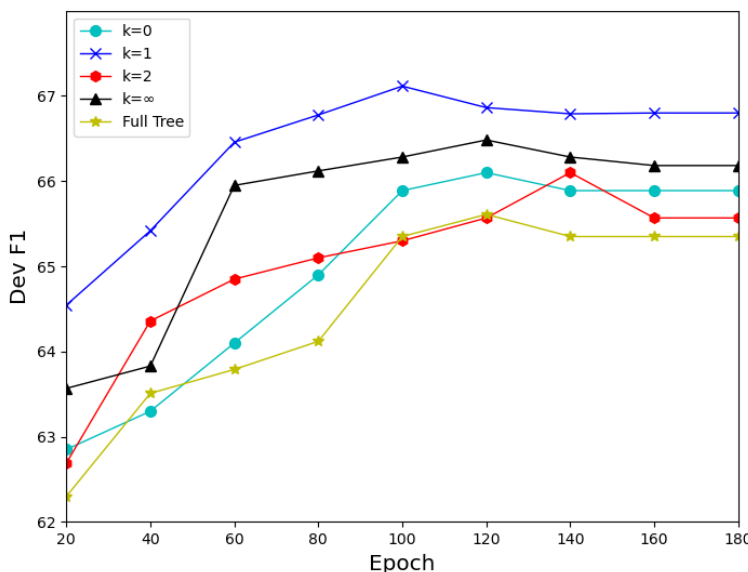
Figure 3. Experimental results in terms of F1 under different epochs whih different pruning strategies.